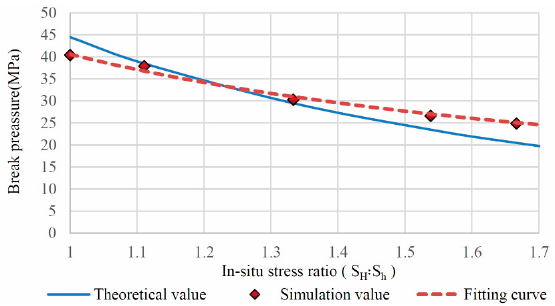
Figure 8. Breakdown pressures obtained from modeling and theoretical calculation based on Equation (16) at different in situ stress ratio ( S H : S h ).